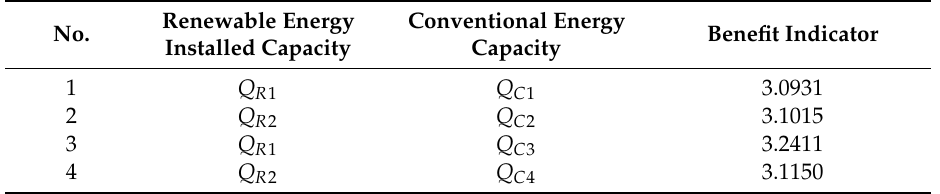
Table 10. Standardized indicators matrix for generation expansion planning